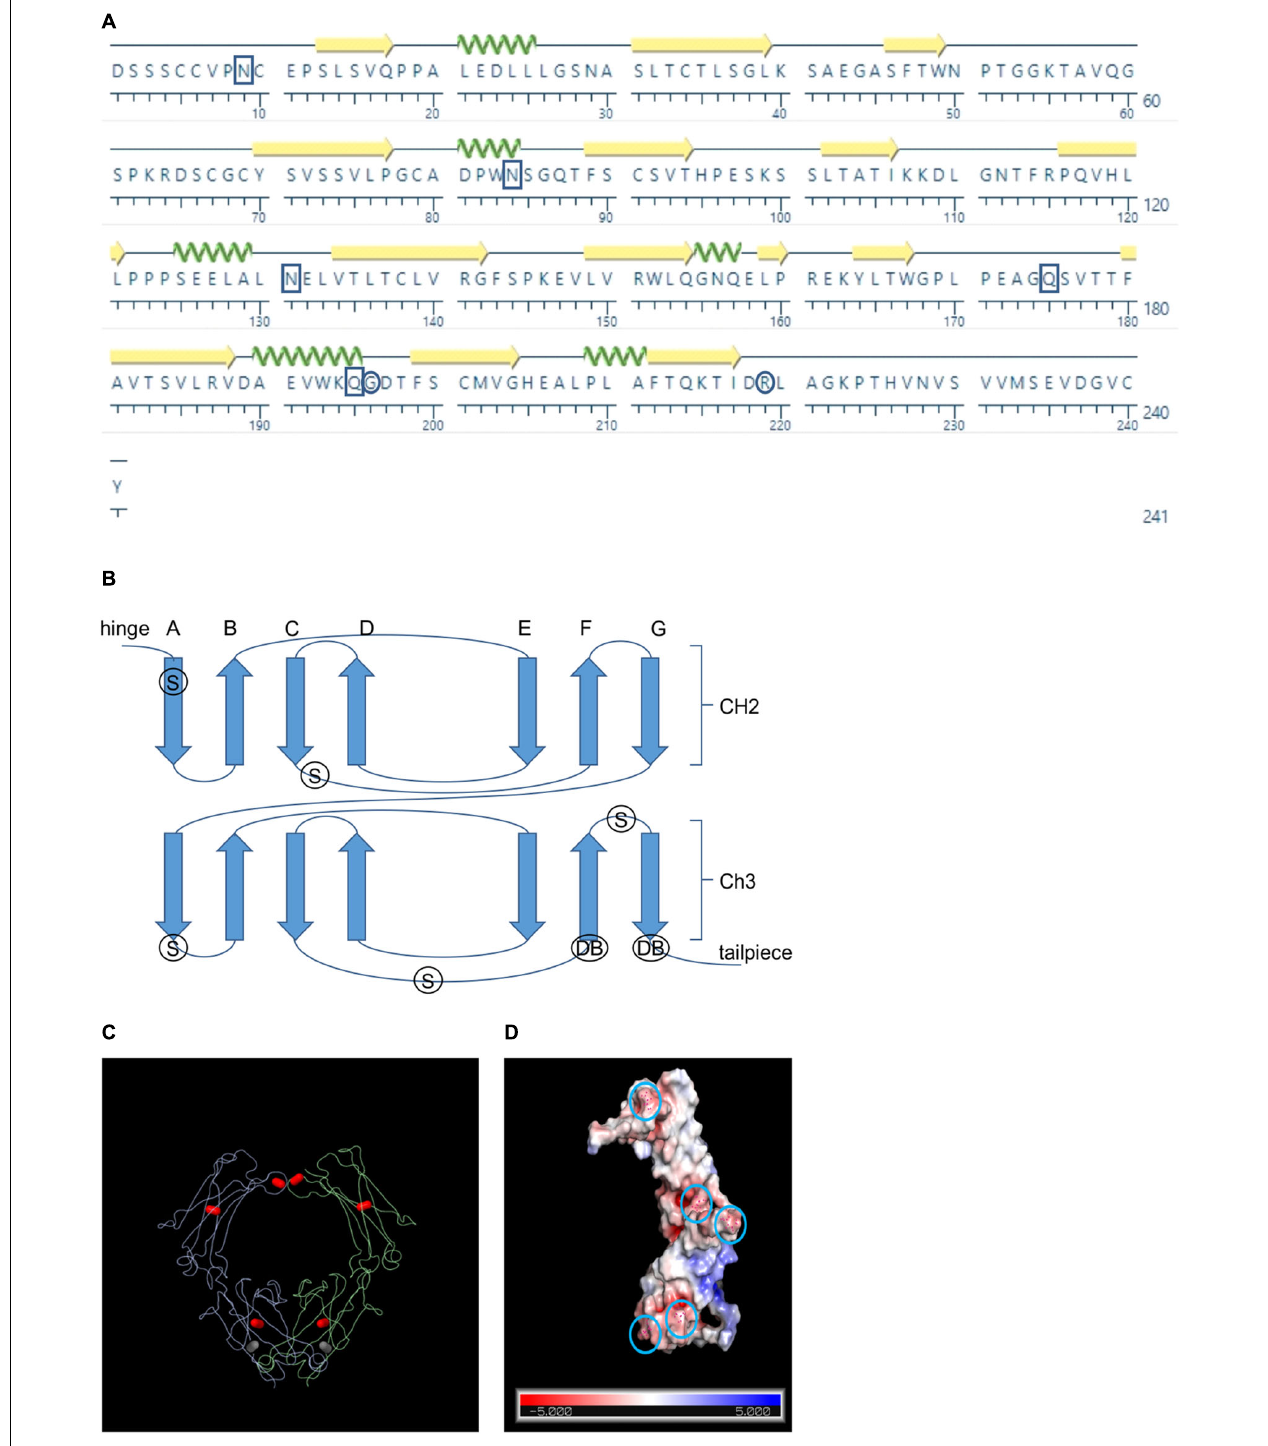
FIGURE 1 | Schematics showing the positions of the rational design candidates. (A) Amino acid sequence of the bovine IgA Fc sequence. Boxes indicate positions of the candidates for supercharging and circles indicate the positions of the candidates for de novo disulfide bonds (B) Schematic showing the Greek key connectivity of the Fc’s β barrel structure. Arrows indicate β strands, S indicates the positions of supercharging candidates and DB indicates the positions of de novo disulfide bond candidates (C) Wire diagram of a dimerized Fc with native intra- and inter- chain disulfides colored in red and the de novo disulfide colored in gray (D) Surface representation of the bovine Fc chain with predicted charge colored on a scale of red indicating more electronegative to blue indicating more electropositive. Circles indicate the positions of the supercharging candidates